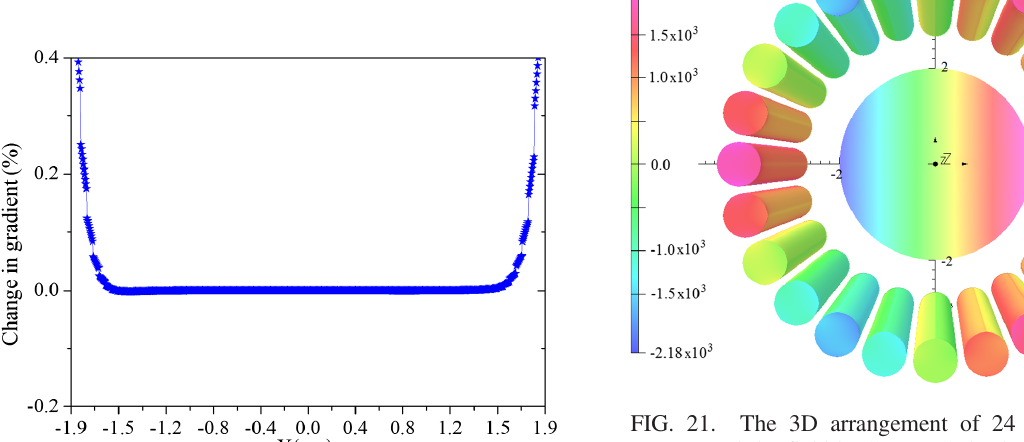
FIG. 18. Variation of the gradient in the good field zone at the center of the magnet for the assembly of 24 PMs each of 3.4 mm radius and after the addition of a gradient tune coil of 10 A/mm 2 current density as obtained from the 2D calculation.